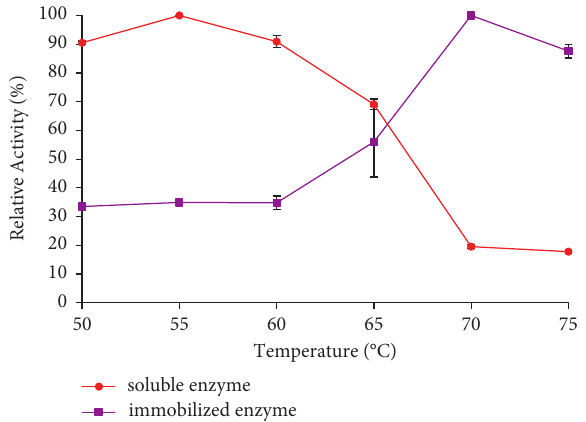
Figure 3: Optimum temperature of the soluble and immobilized enzymes. The data are presented as mean ± SD; n � 2; a significant difference � p < 0 . 05. The error bars represent standard deviations from two replicates measurements.